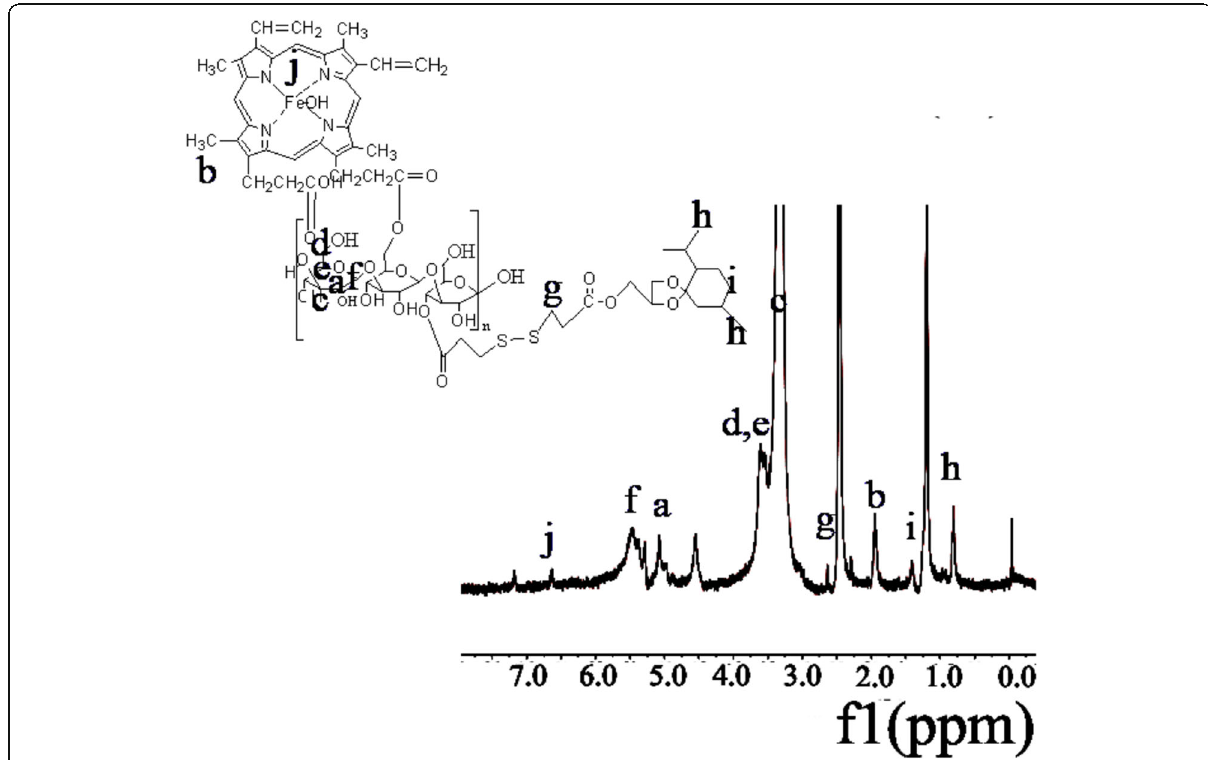
Fig. 2 The 1 H-NMR spectra of